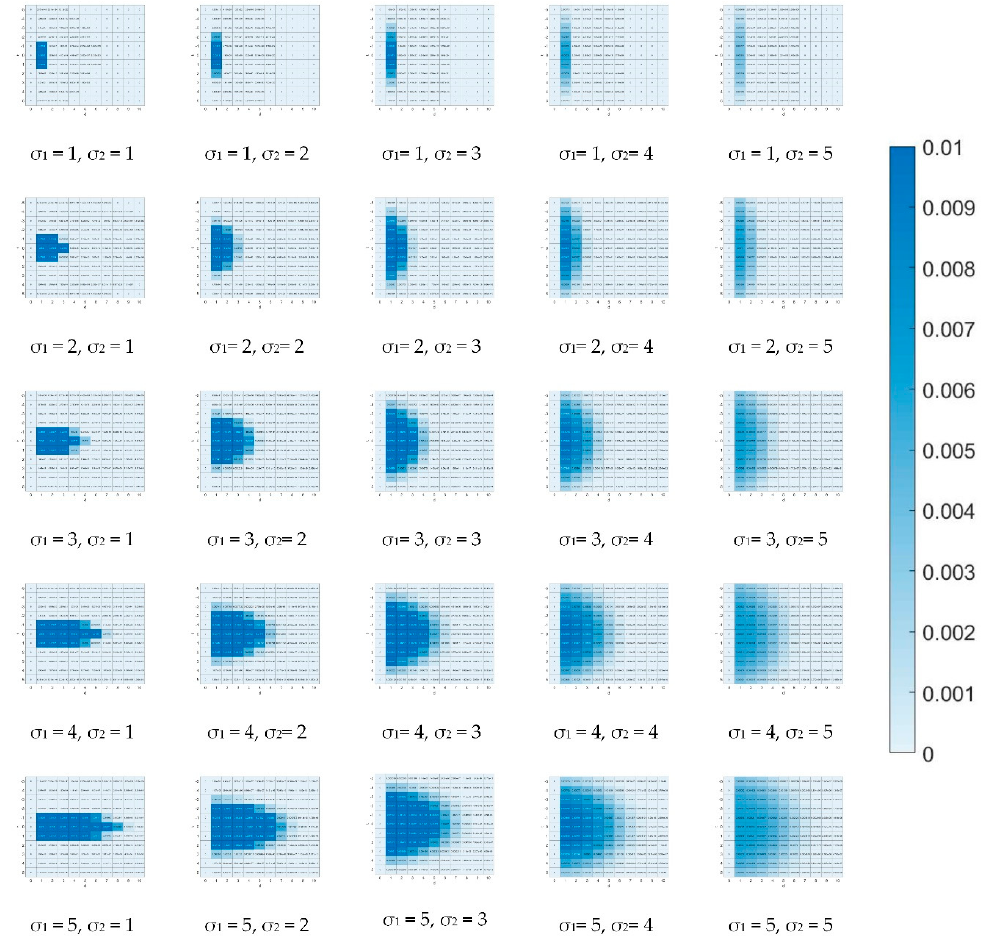
Figure 12. Heat maps of evaluation models with different σ 1 and σ 2.